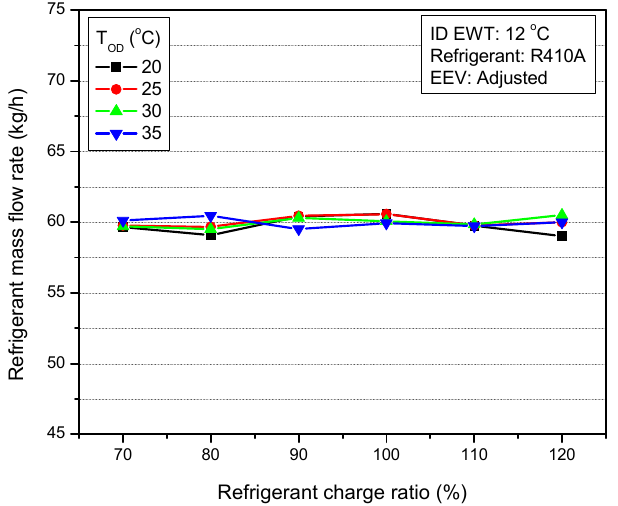
Figure 4. Refrigerant charge flow rate with variation of refrigerant charge amount and T OD .